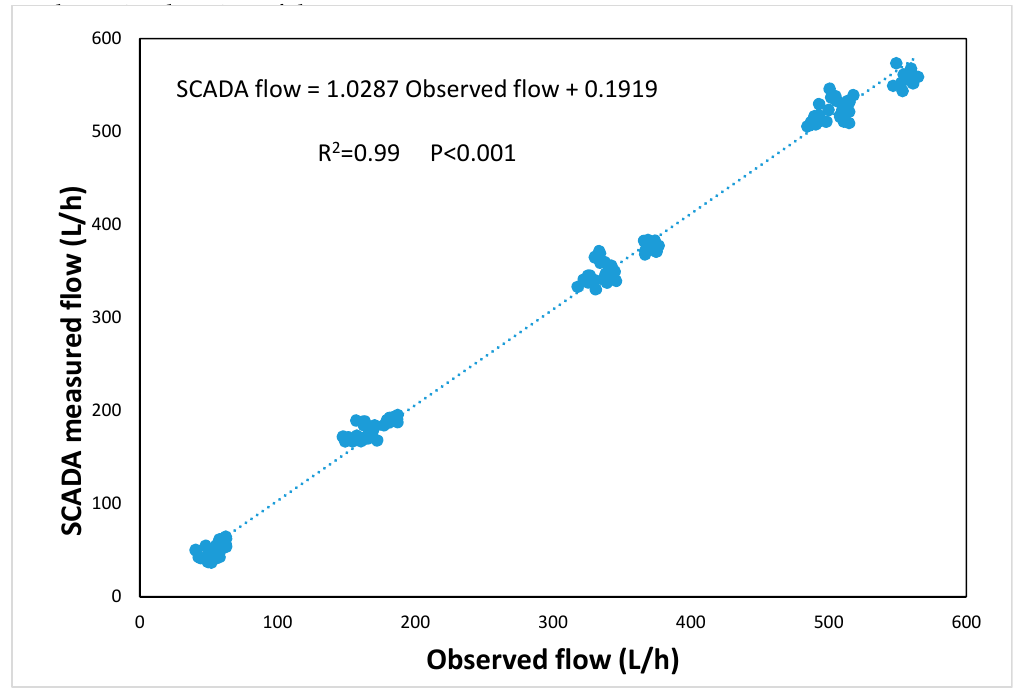
Figure 5. Relationship between the observed flow (L/h) and the measured flow by the SCADA system (L/h) for all water meters at different locations and measuring times.